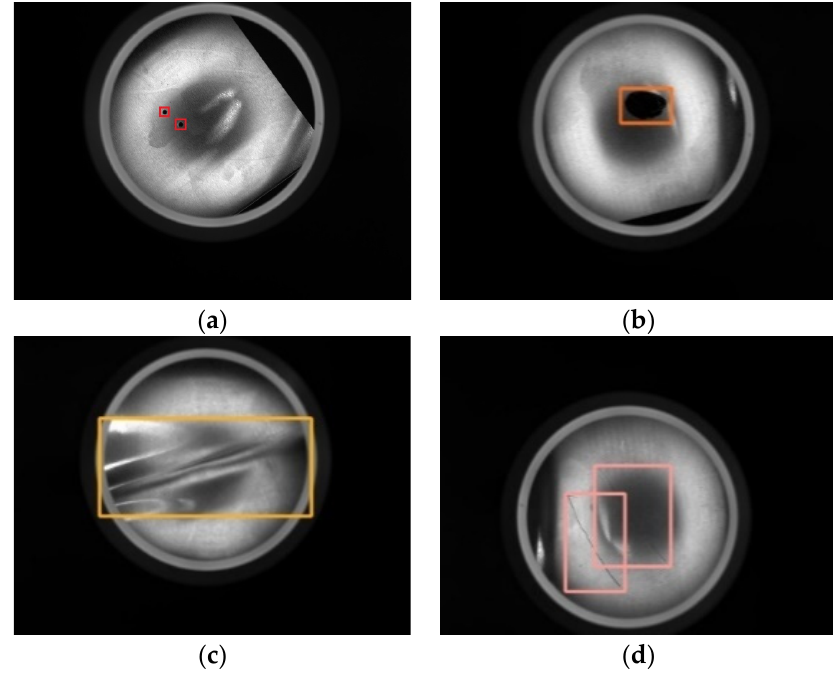
Figure 1. The four defects of aluminum profiles: ( a ) pinhole; ( b ) dirt; ( c ) fold; ( d ) scratch.